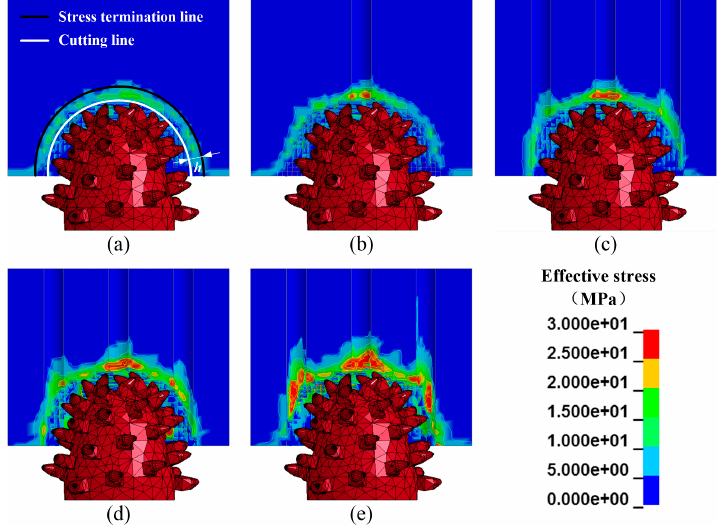
Figure 7. Effective stress contours for a cross-section of the rock center at the advance time of 25 s: ( a ) no holes; ( b ) one hole; ( c ) five holes; ( d ) nine holes; and ( e ) 13 holes.